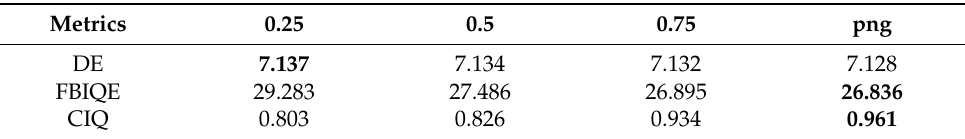
Table 4. Performance comparison of the proposed method on test images in terms of the DE, FBIQE, and CIQ metrics.